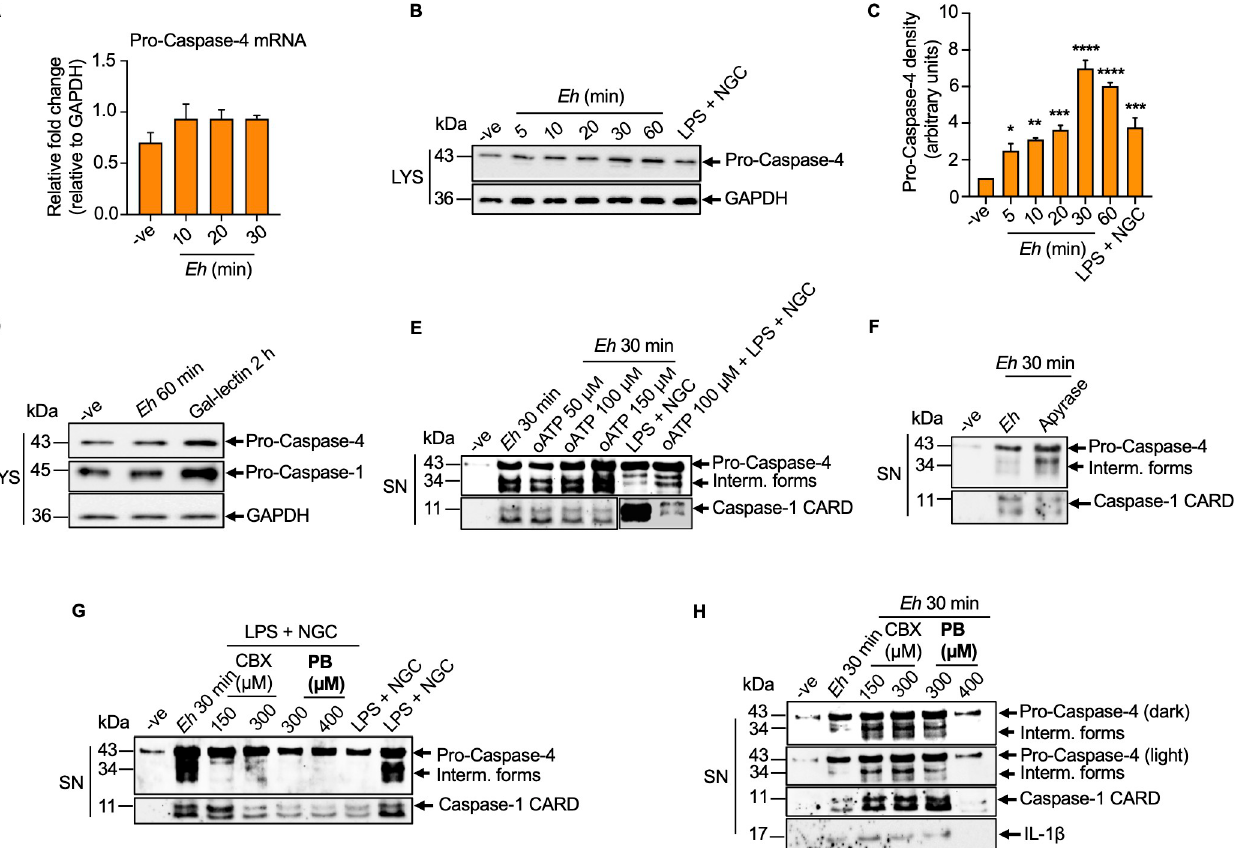
Fig 3. Mechanisms of E . histolytica -induced caspase-4 activation. ( A-C ) Eh upregulated pro-caspase-4 expression and transcription in a time-dependent manner. ( A ) Quantitative PCR was conducted to investigate if Eh increased pro-caspase-4 transcription. ( B, C ) Macrophages were stimulated with Eh at 20:1 ratio for increasing amount of time. Equal amount of lysate (LYS) was resolved on SDS-PAGE and immunoblotted for pro-caspase-4 detection. Blots were reprobed for GAPDH. Densitometry was performed to assess pro-caspase-4 proteins and the negative (cells only) acted as an internal control. ( D ) Macrophages were treated with native Eh Gal-lectin (500 ng/mL) for 2 h and pro-caspase-4, pro-caspase-1 and GAPDH levels were determined by western blot. ( E-H ) Caspase-4 activation requires ATP signaling via the P2X 7 receptor and pannexin-1 channels. ( E ) Macrophages were pretreated with oxidized ATP (oATP) for 2 h and then stimulated with Eh for 30 min. ( F ) Immunoblot analysis of active caspase-4 and caspase-1 in macrophages stimulated for 30 min with Eh with the addition of apyrase (20 U/mL). ( G ) Inhibition of caspase-4 with carbenoxolone (CBX), connexin/pannexin channel dual inhibitor, or pannexin channel inhibitor probenecid (PB). LPS and NGC were used as a positive control. Left: LPS (100 ng/ml) priming for 30 min and NGC (5 μ M) stimulation for 30 min; right: LPS (50 ng/ml) priming for 30 min and NGC (10 μ M) stimulation for 30 min. ( H ) Macrophages were incubated with CBX and PB for 30 min, prior to Eh stimulation for 30 min. Cell supernatant (SN) was TCA precipitated and cells were washed and lysed. Equal amount of supernatants and lysed cell lysates was loaded onto SDS-PAGE and immunoblot analysis was performed for caspase-4, caspase-1 and IL-1 β . Data and immunoblots are representative of at least three independent experiments (n = 3) and statistical significance was calculated with one-way ANOVA, followed by Bonferroni’s post-hoc test ( � p < 0.05, �� p < 0.01, ��� p < 0.001 ���� p < 0.0001). Bars represent mean ± SEM.